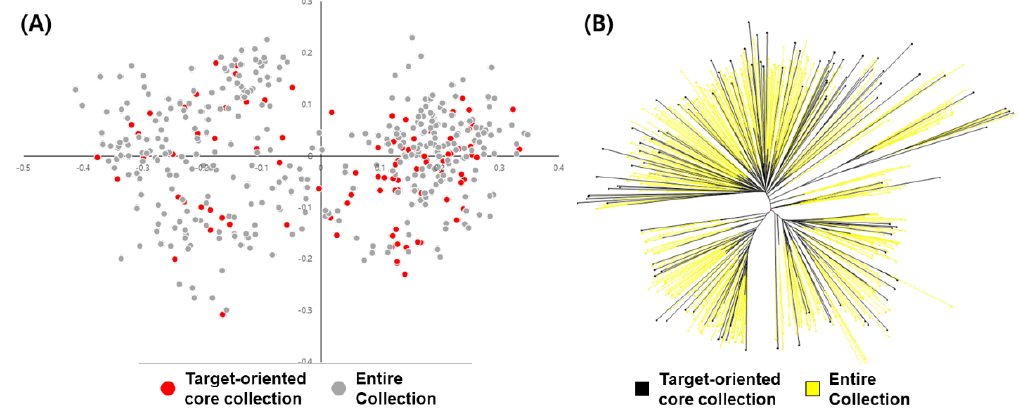
Figure 4. Distribution of tea accessions in the core collections using molecular data. ( A ) Principal coordinate analysis; ( B ) Neighbor-Joining Tree.